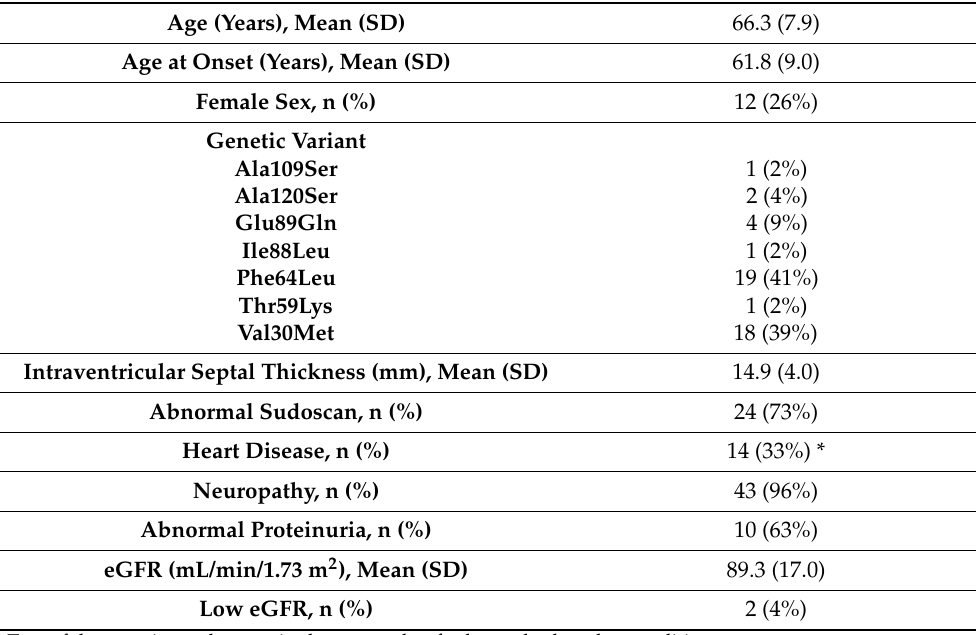
Table 1. Baseline characteristics of the enrolled